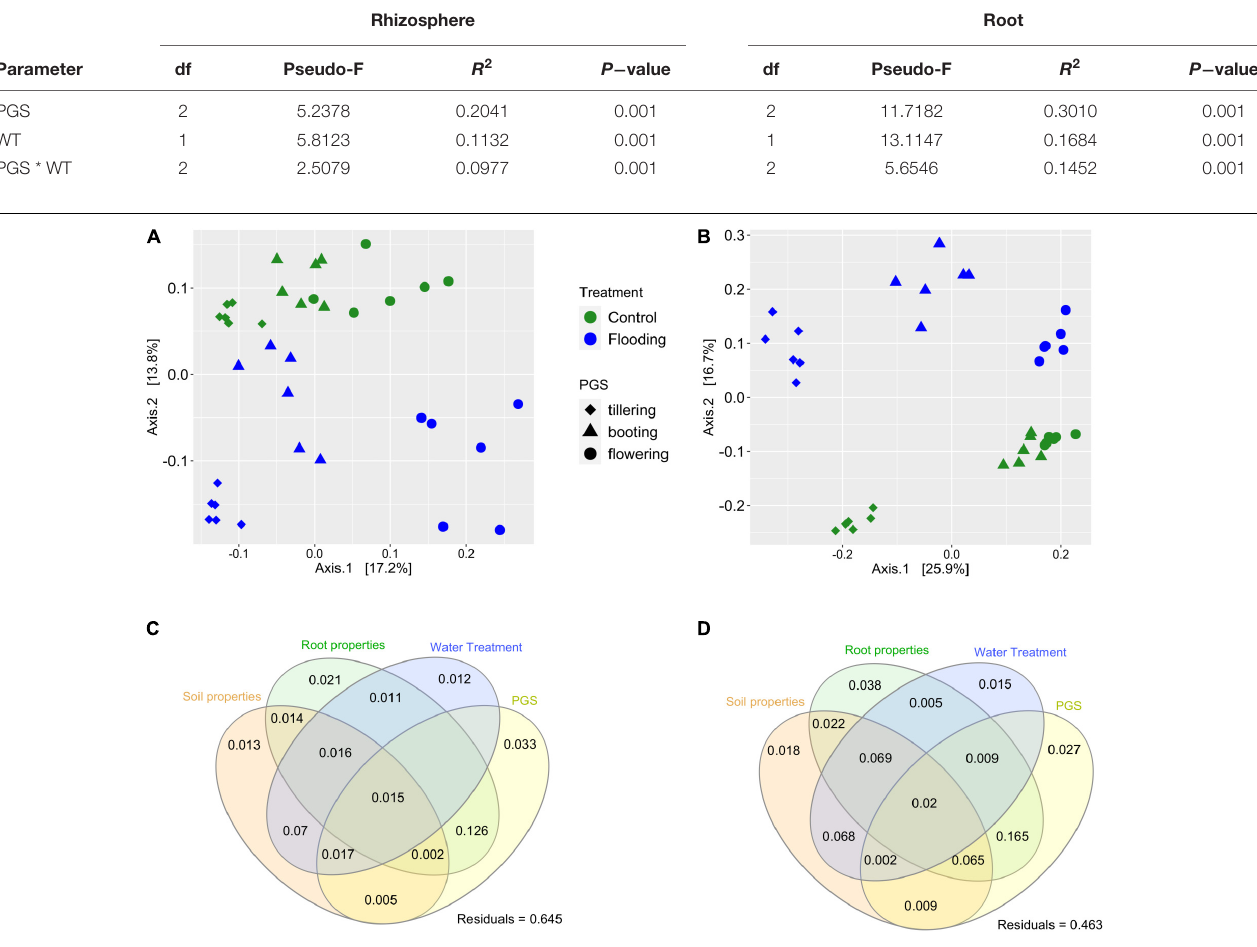
FIGURE 3 | Principal coordinates analysis (PCoA) of the bacterial communities detected in the rhizosphere (A) and in the root (B) compartment. Variation partitioning analysis, illustrating the effects soil parameters, root traits, watering treatment and plant growth stage (PGS) in the community for the rhizosphere (C) and root (D) compartment. Each ellipse represents the portion of variation accounted by each factor. Shared variance is represented by the intersecting portions of the ellipses. Values < 0 are not shown. Unexplained variation (residuals) is reported in the